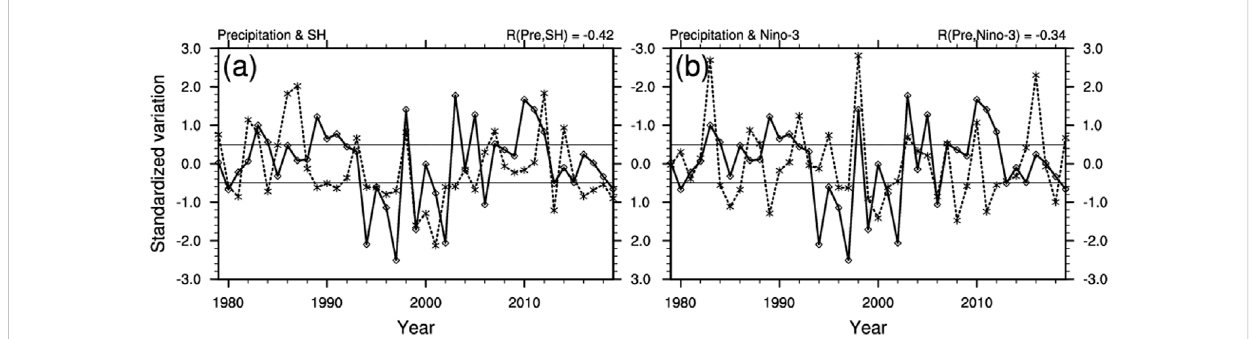
StandardizedseriesofmidsummerprecipitationinSouthChina(solidblackline;theaxisrepresentingprecipitationisinverted) withthe (A) springSH (dotted black line) and the (B) preceding winter Niño-3 index (dotted black